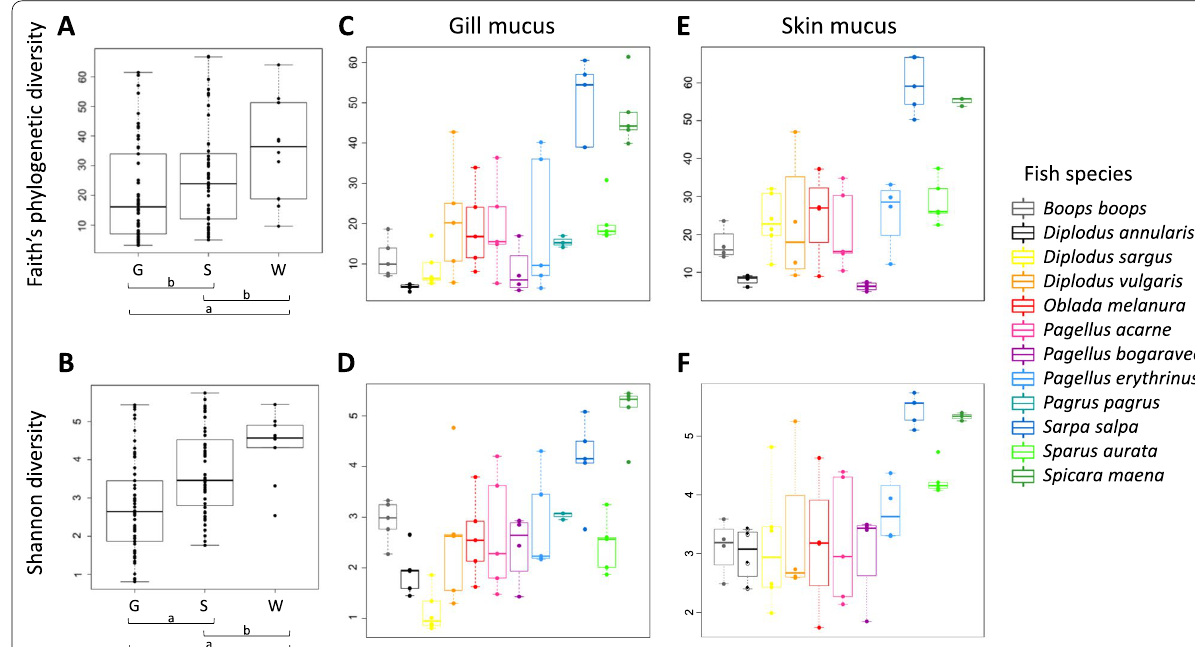
Fig. 1 Comparison of alpha diversity values between habitats and host fish species. Faith’s phylogenetic diversity and Shannon diversity index for skin mucus (S), gill mucus (G) and water communities (W) ( A , B ) and within host fish species for gill mucus ( C , D ) and skin mucus ( E , F ). Significant (a) and non‑significant (b) differences between tissue are indicated (Conover‑Iman test (post hoc test), p < alpha/2 non‑significant differences in skin and gill mucus diversity between fish species are available in Additional file 1: Table